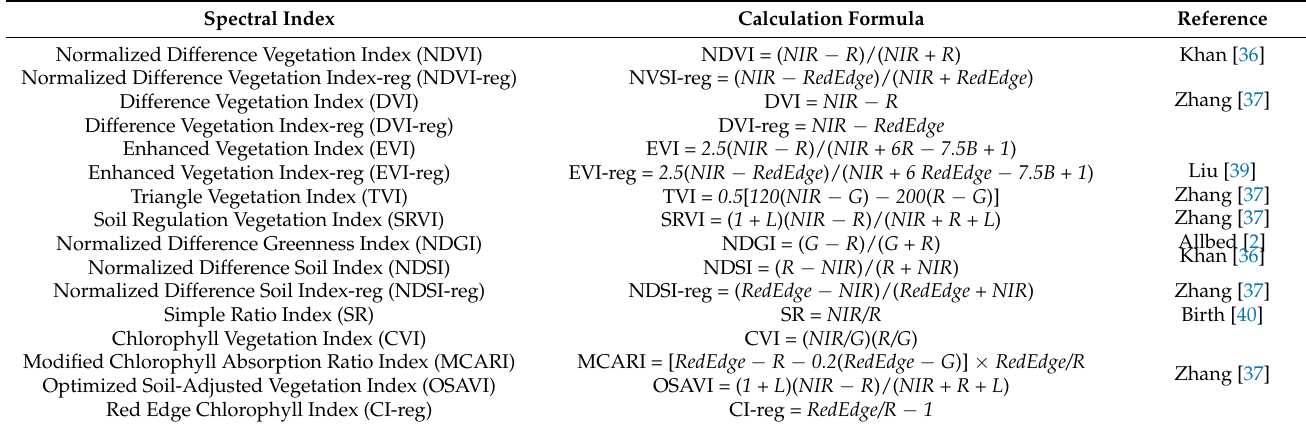
Table 3. The calculation formulae of the vegetation